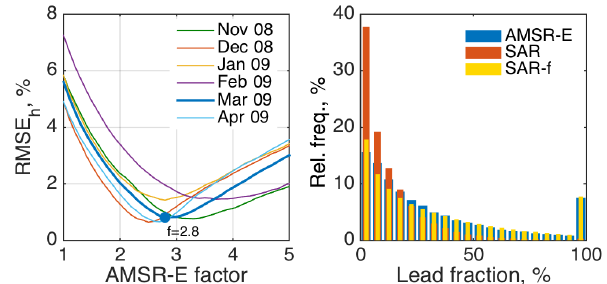
Figure 8. Left: Root mean square error (RMSE h , %, Eq. 3) as a measure of difference between the histogram of AMSR-E lead frac- tion (LF) and SAR LF multiplied by different values of f (AMSR-E factor). To demonstrate the principle, March 2009 is highlighted by a bold blue line with a minimum factor of 2.8. Right: original his- togram of AMSR-E LF and SAR LF data for the full winter Novem- ber 2008–April 2009, and SAR LF multiplied by the respective fac- tor for each month (yellow